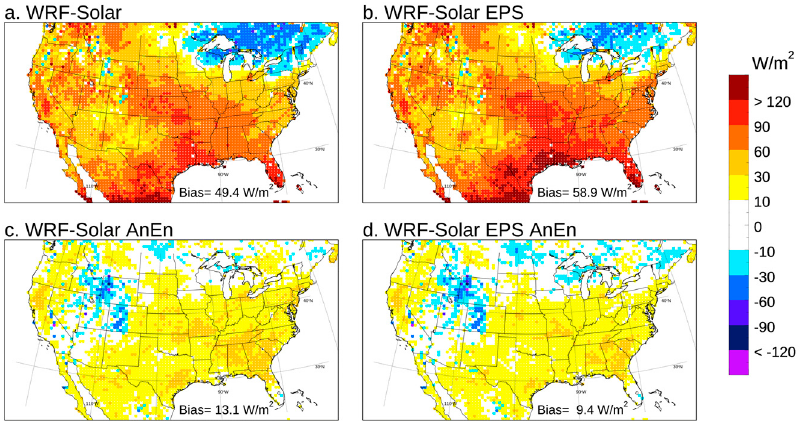
Figure A2. Bias computed for DNI over the year 2018 for the forecast lead times from +24 to +48 h. The value in the legend at the bottom of each panel indicates the bias computed by pooling all the grid points and lead times together.